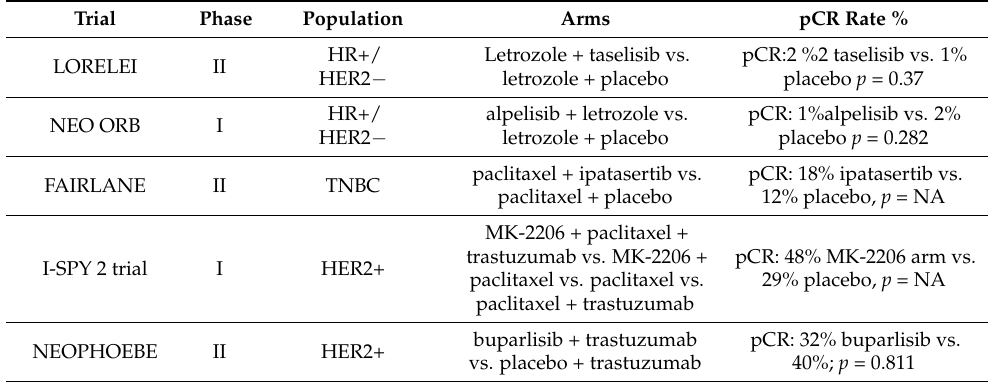
Table 3. Clinical trials of PI3K/AKT/mTOR inhibitors in PI3k-mutated early breast cancer. Trial Phase